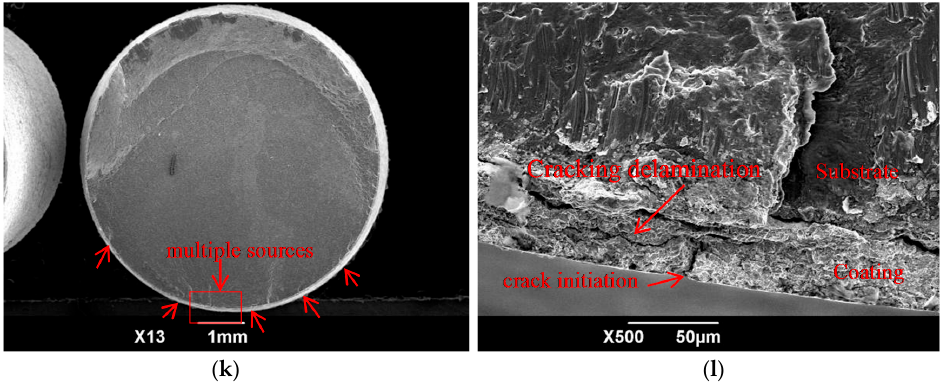
Figure 10. Morphologies of fracture and crack initiation sites of TC21 samples with different surface states: ( a ) BM; ( b ) BM crack initiation site; ( c ) SP + H; ( d ) SP + H crack initiation site; ( e ) SP + H + DP; ( f ) SP + H + DP crack initiation site; ( g ) SP + H + DP + SP1; ( h ) SP + H + DP + SP1 crack initiation site;